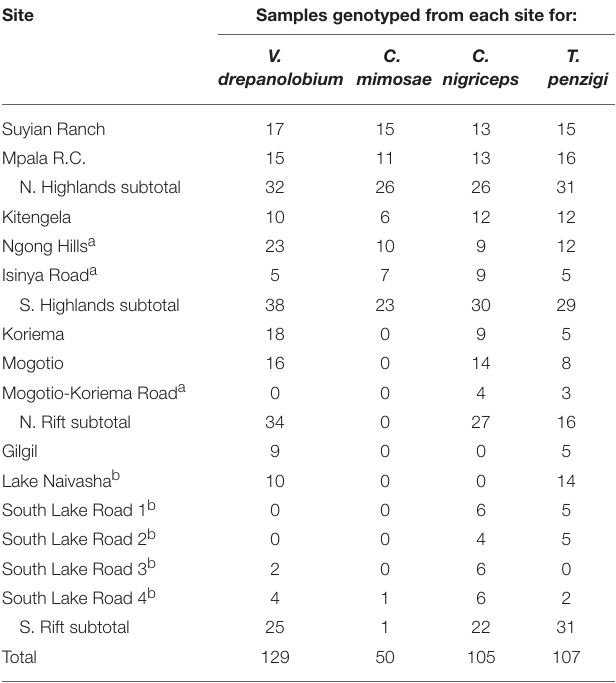
TABLE 2 | Sample sizes for population genomic analyses. Site Samples genotyped from each site